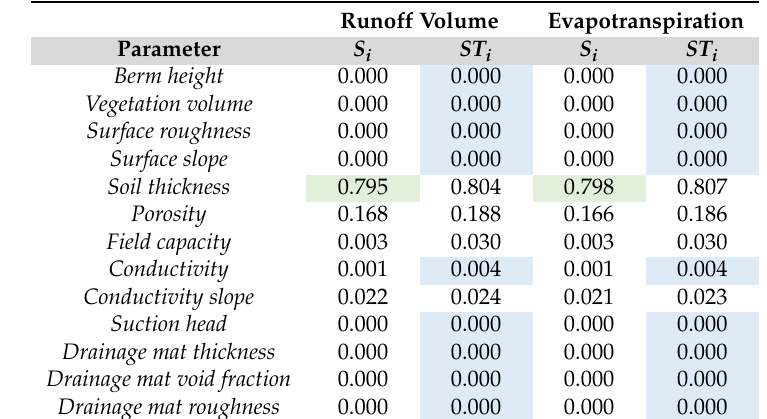
Table 2. Result of the long-term sensitivity analysis for the green roof; blue-shaded: Non-influential parameters ( ST i < 0.01), green-shaded: Most influential parameters (highest S i